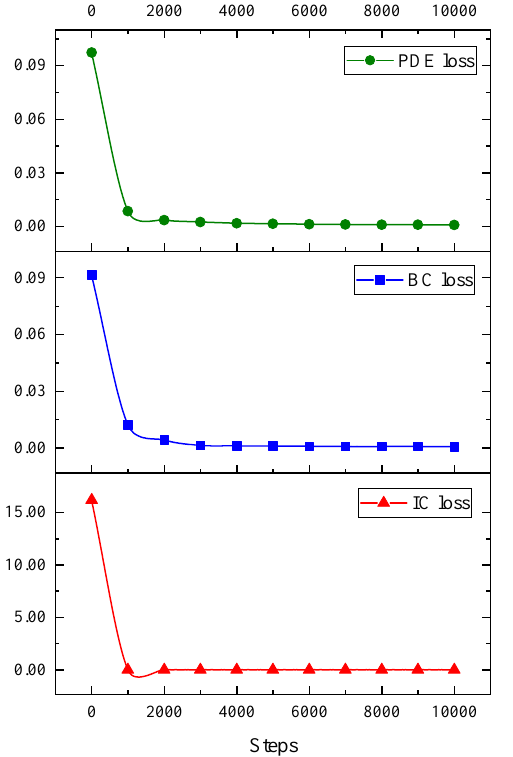
Figure 11. Training results for two-dimensional consolidation model of drainage at the top and bottom boundaries.